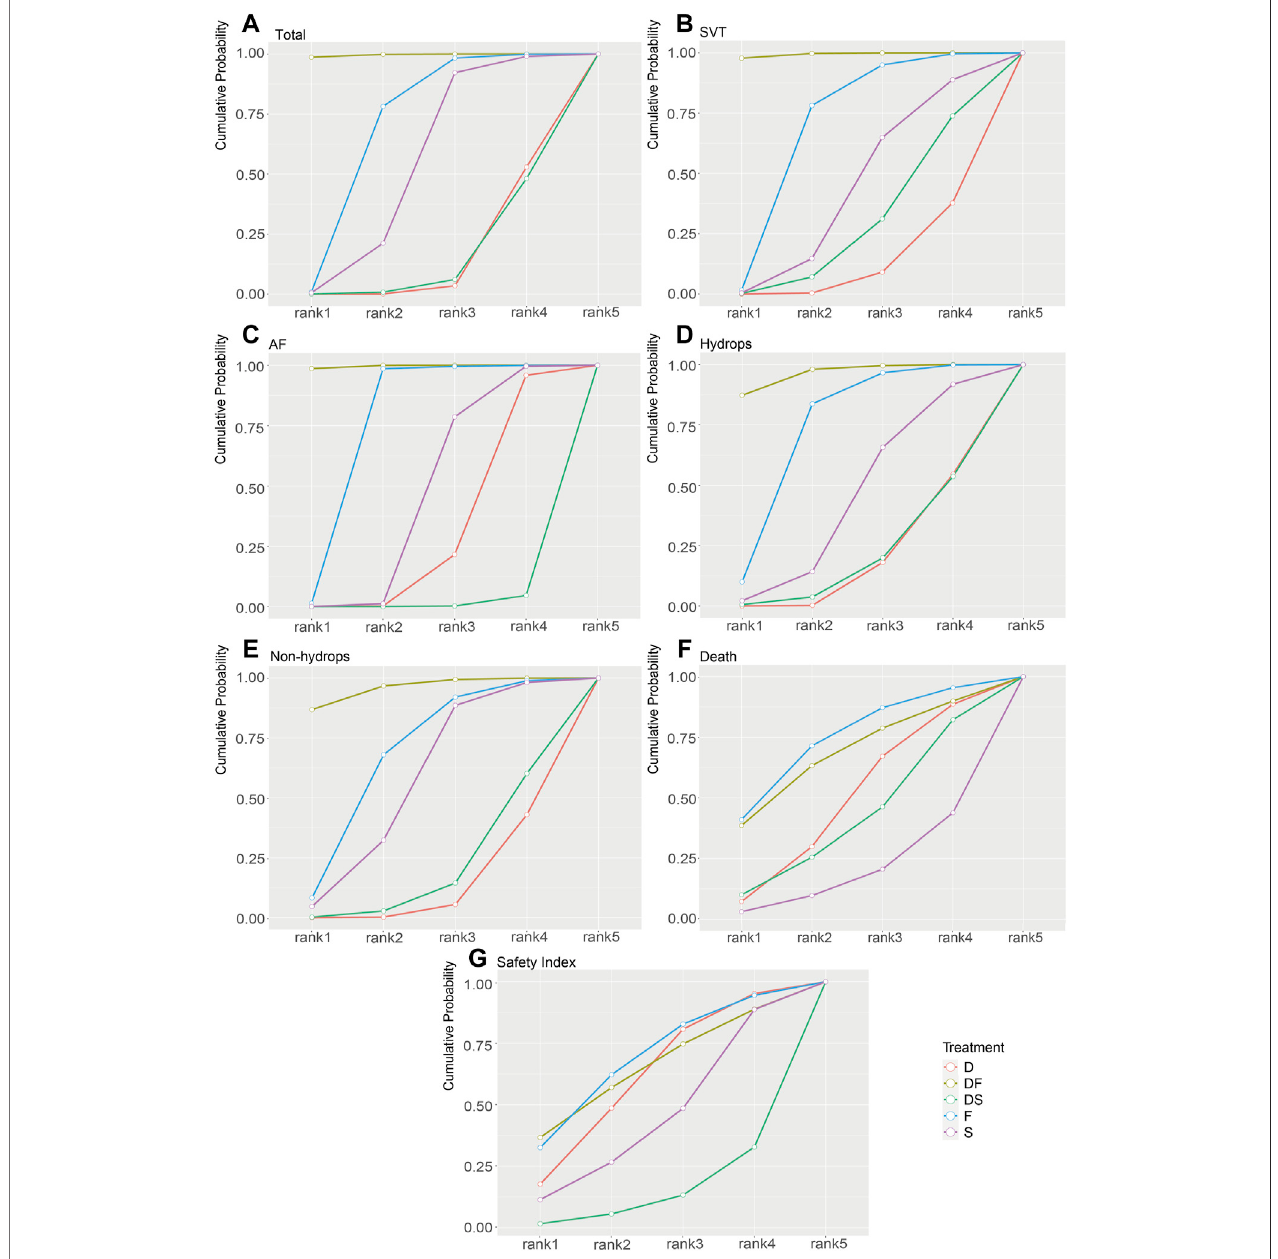
FIGURE4| Rank-lineplotsoftheenrolledanalyses.Thecumulativeprobabilityofsuperiorityisshownasalinechart,andtheareaunderthecurve(AUC)represents the rankings, with a larger AUC indicating a higher rank. (A) Total group. (B) SVT group. (C) AF group. (D) Hydrops group. (E) Non-hydrops group. (F) Death rate in the total group. (G) Safetyindex inthetotal group.D, digoxinmonotherapy;DF,digoxin and fl ecainidecombinationtherapy;DS, digoxinand sotalolcombinationtherapy;F, fl ecainide monotherapy; S, sotalol monotherapy; SVT, supraventricular tachycardia; AF atrial fl utter.